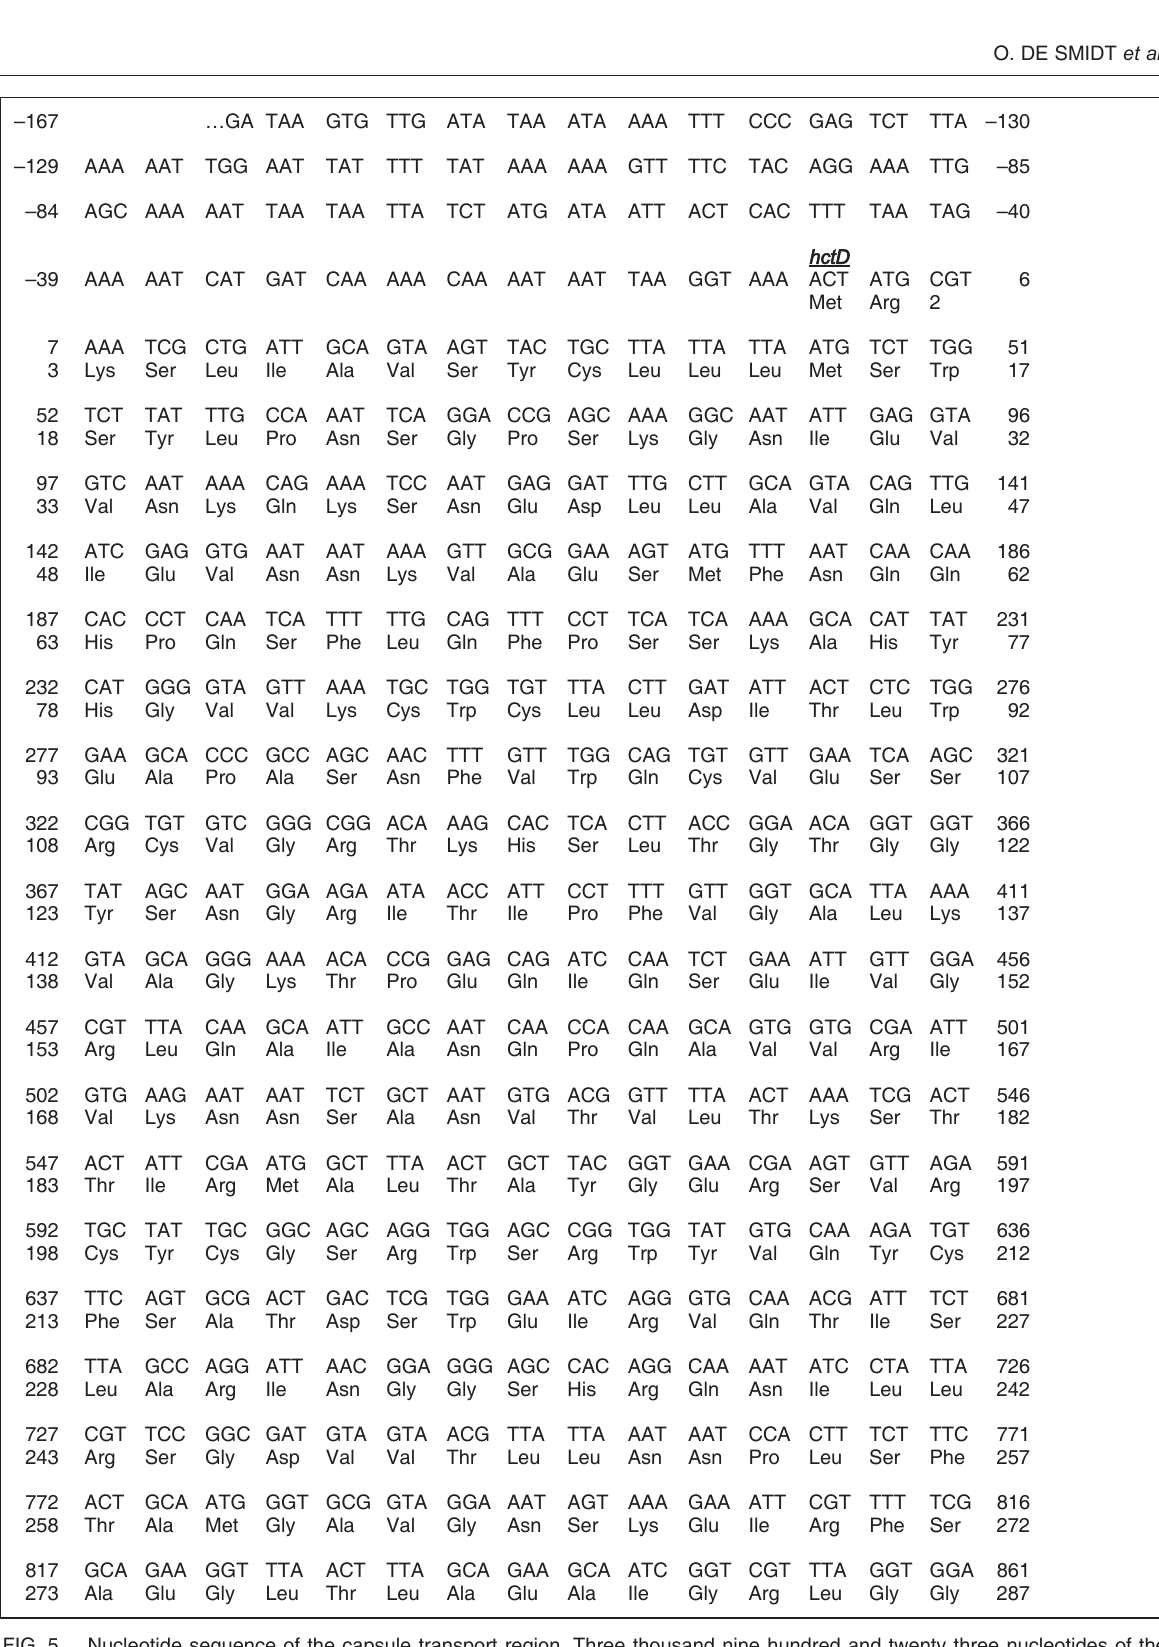
FIG. 5 Nucleotide sequence of the capsule transport region. Three thousand nine hundred and twenty three nucleotides of the sequence are shown, from arbitrary points 167 bp upstream of hctD to 131 bp downstream of hctA . The four open reading frames are indicated as hctD , hctC , hctB and hctA , in each case from the first ATG, with the translated peptide sequence beneath. The underlined regions are referred to in the text